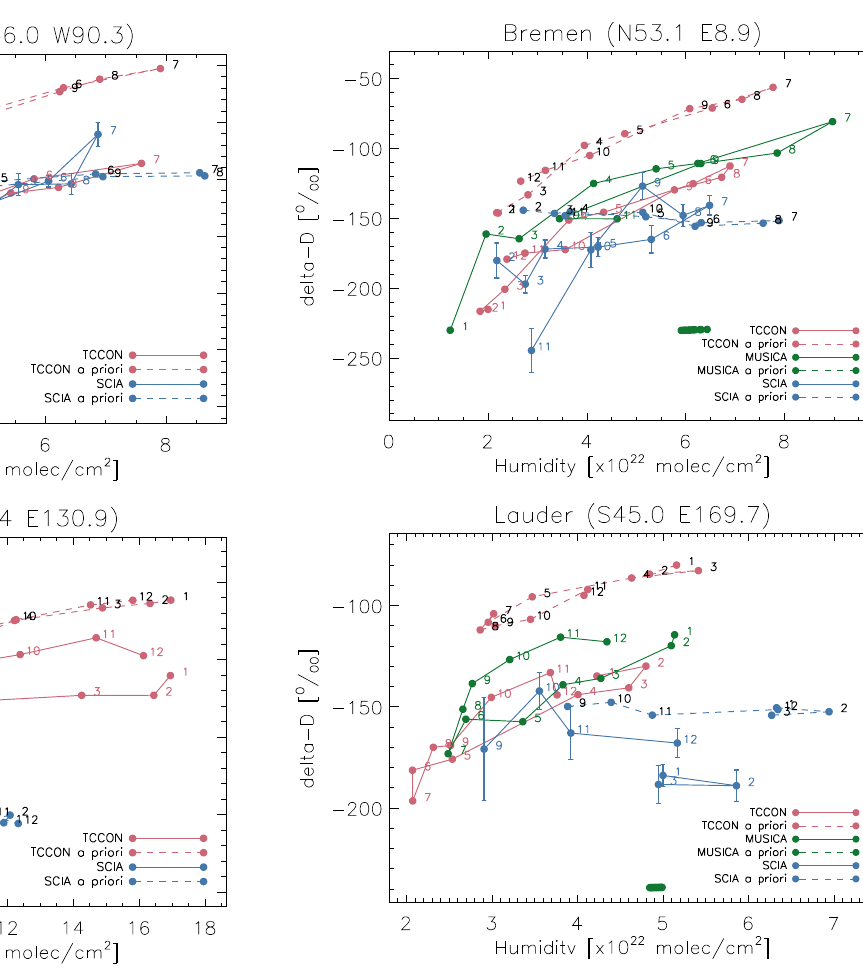
Figure 11. Same as Fig. 10 but for the two stations participating in Figure 10. Monthly means of δD as a function of humidity for the both TCCON and MUSICA TCCON stations Park Falls (top) and Darwin (bottom) compared Fig. 10. Monthly means of δ D as a function of humidity for the TC- Fig. 11. Same as Fig. 10 but now for the two stations participating to spatially co-located SCIAMACHY measurements. Subsequent CON stations Park Falls (left top) and Darwin (right bottom), com- in both TCCON and MUSICA networks. months are numbered and connected by lines. The prior information ::: ::::: pared to spatially co-located SCIAMACHY measurements. Subse- is shown with dashed lines and black numbers. quent months are numbered and connected by lines. The prior in- formation is shown with dashed lines and black numbers.